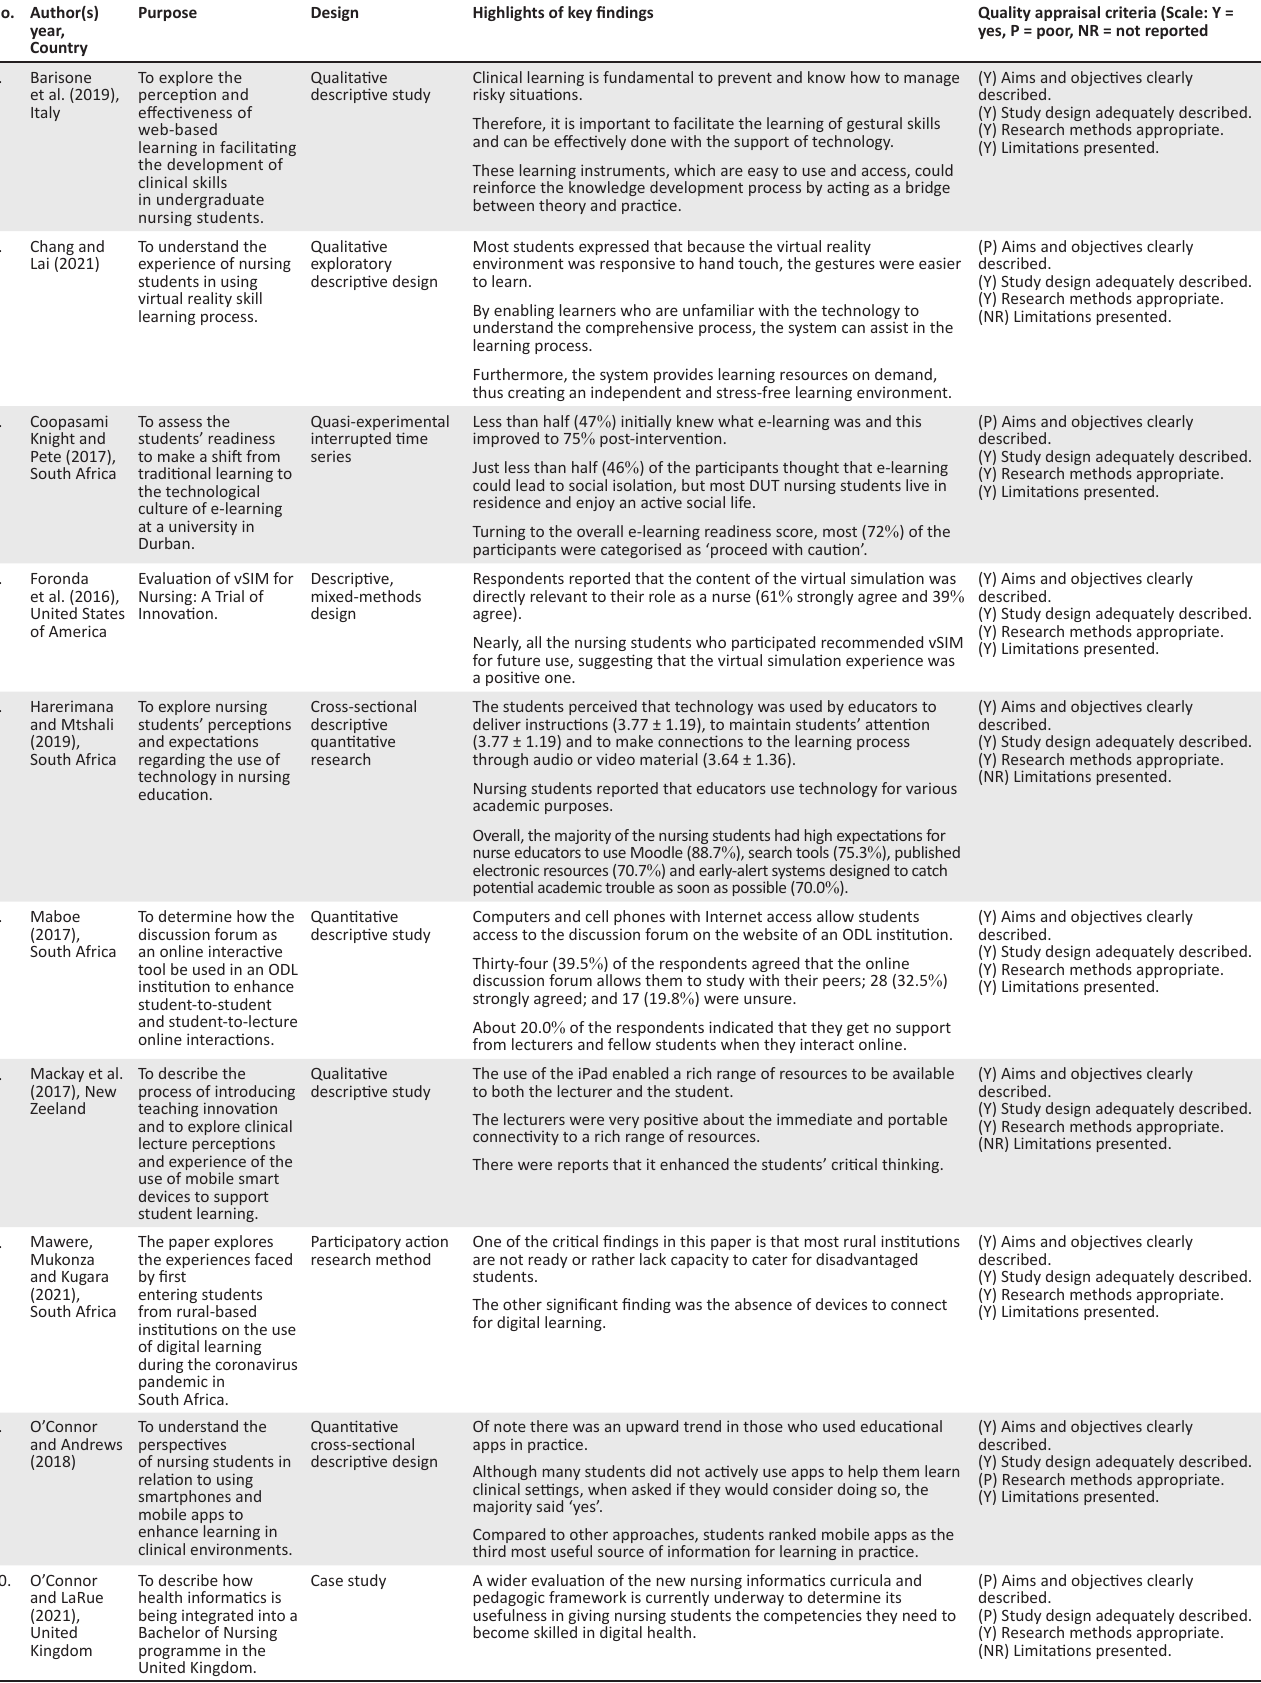
TABLE 1: Quality appraisal of